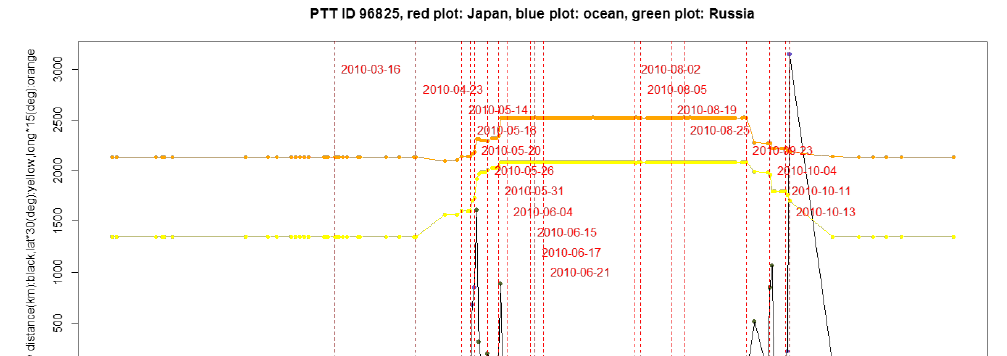
Figure 4. Change points detected by daily distance, latitude, and longitude